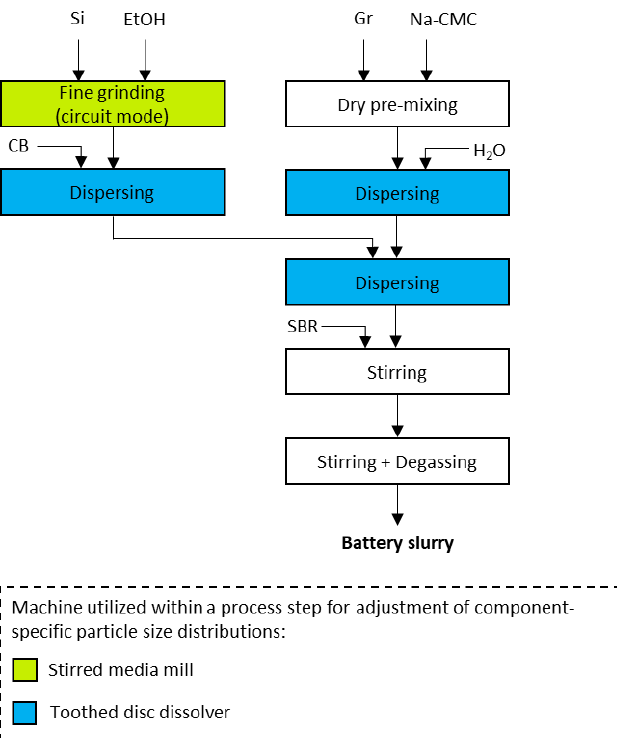
Figure 3. Process scheme for the production of battery slurries using the reference process within a tooth disc dissolver.